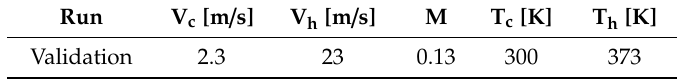
Table 1. Flow parameters used in this study.